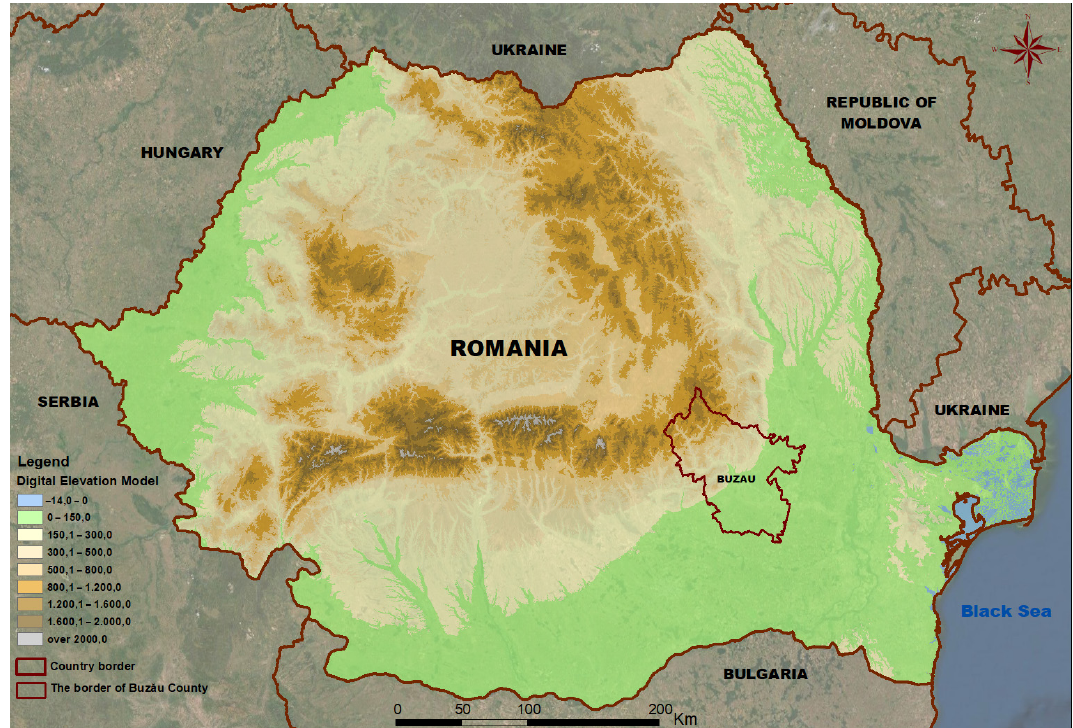
Figure 1. Location of the study area in European context (the national level–Romania and the county level–Buz ă u County). The map also displays the elevation, based on a Digital Elevation Model (map created by the authors).